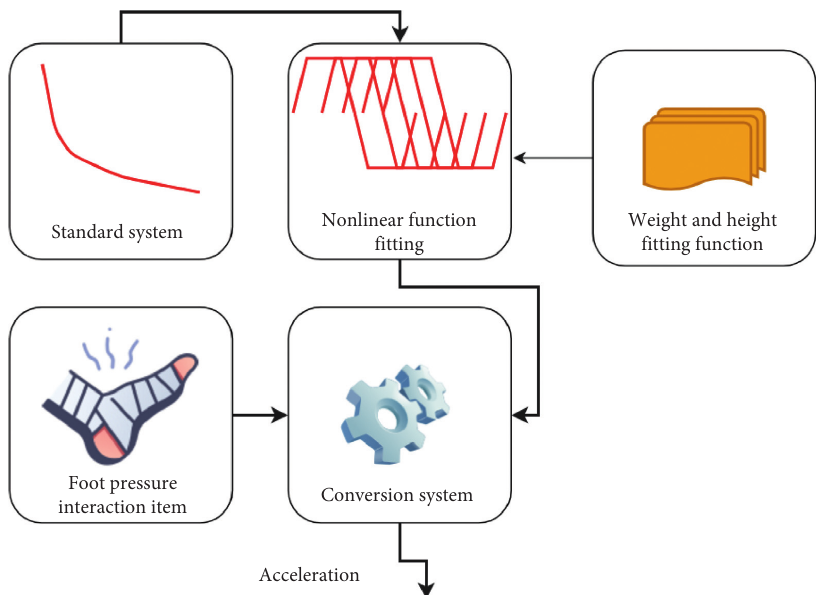
Figure 9: Block diagram of foot pressure coupled with dynamic motion